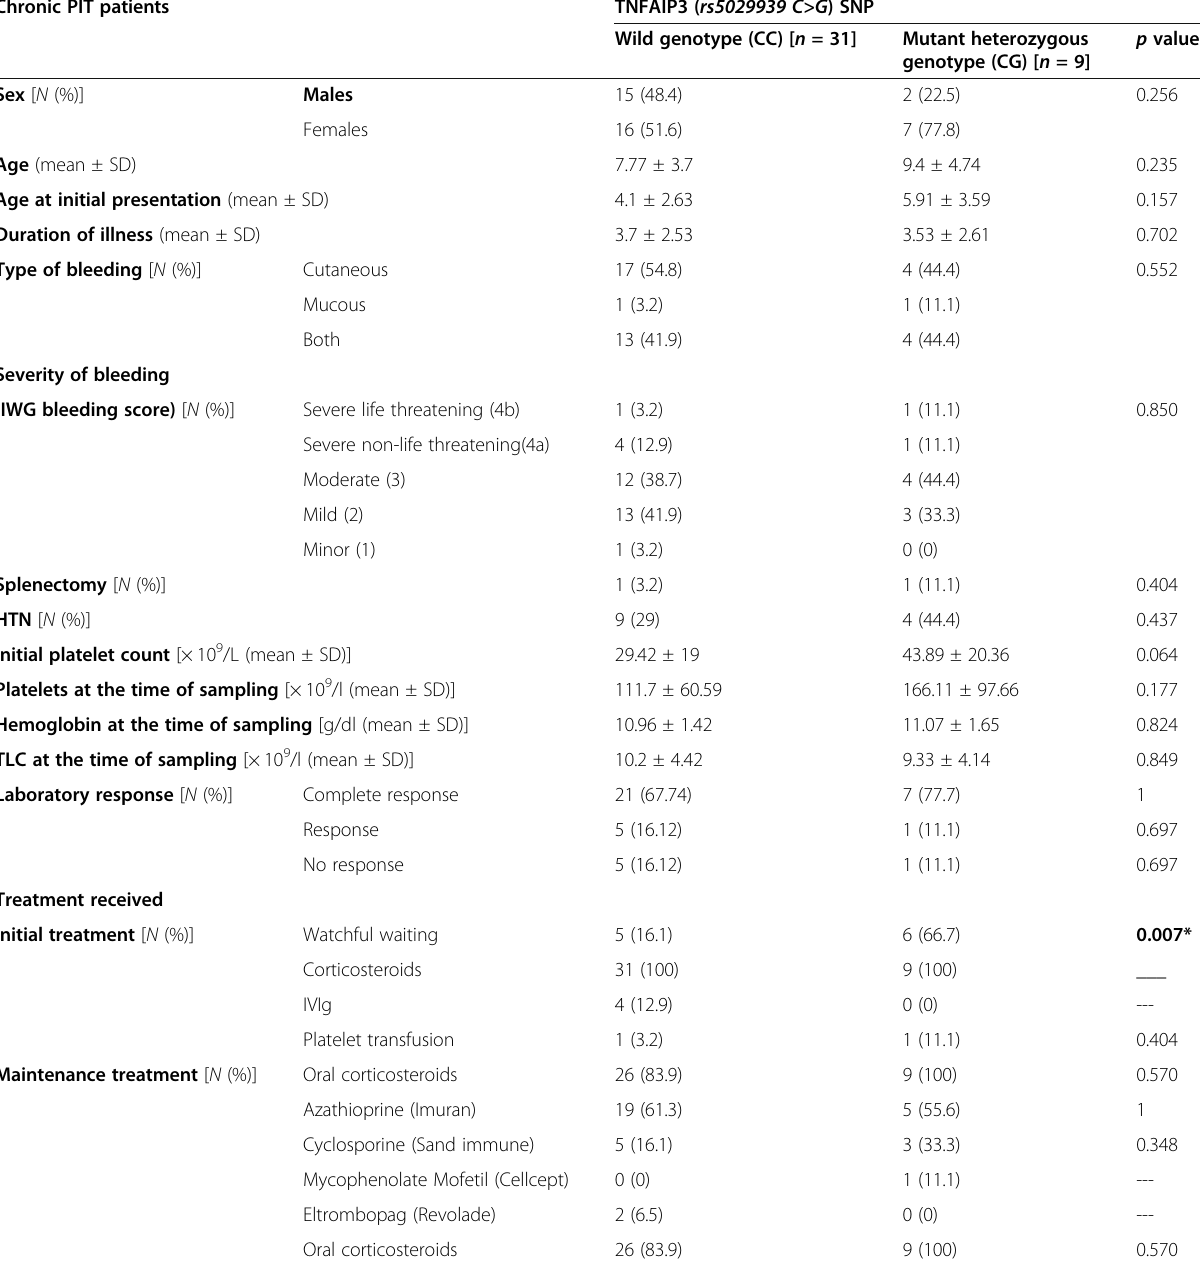
Table 4 Comparison of wild (CC) and heterozygous mutant (CG) genotypes of TNFAIP3 ( rs5029939 C>G ) SNP in chronic PIT patients as regards platelet counts and treatment response Chronic PIT